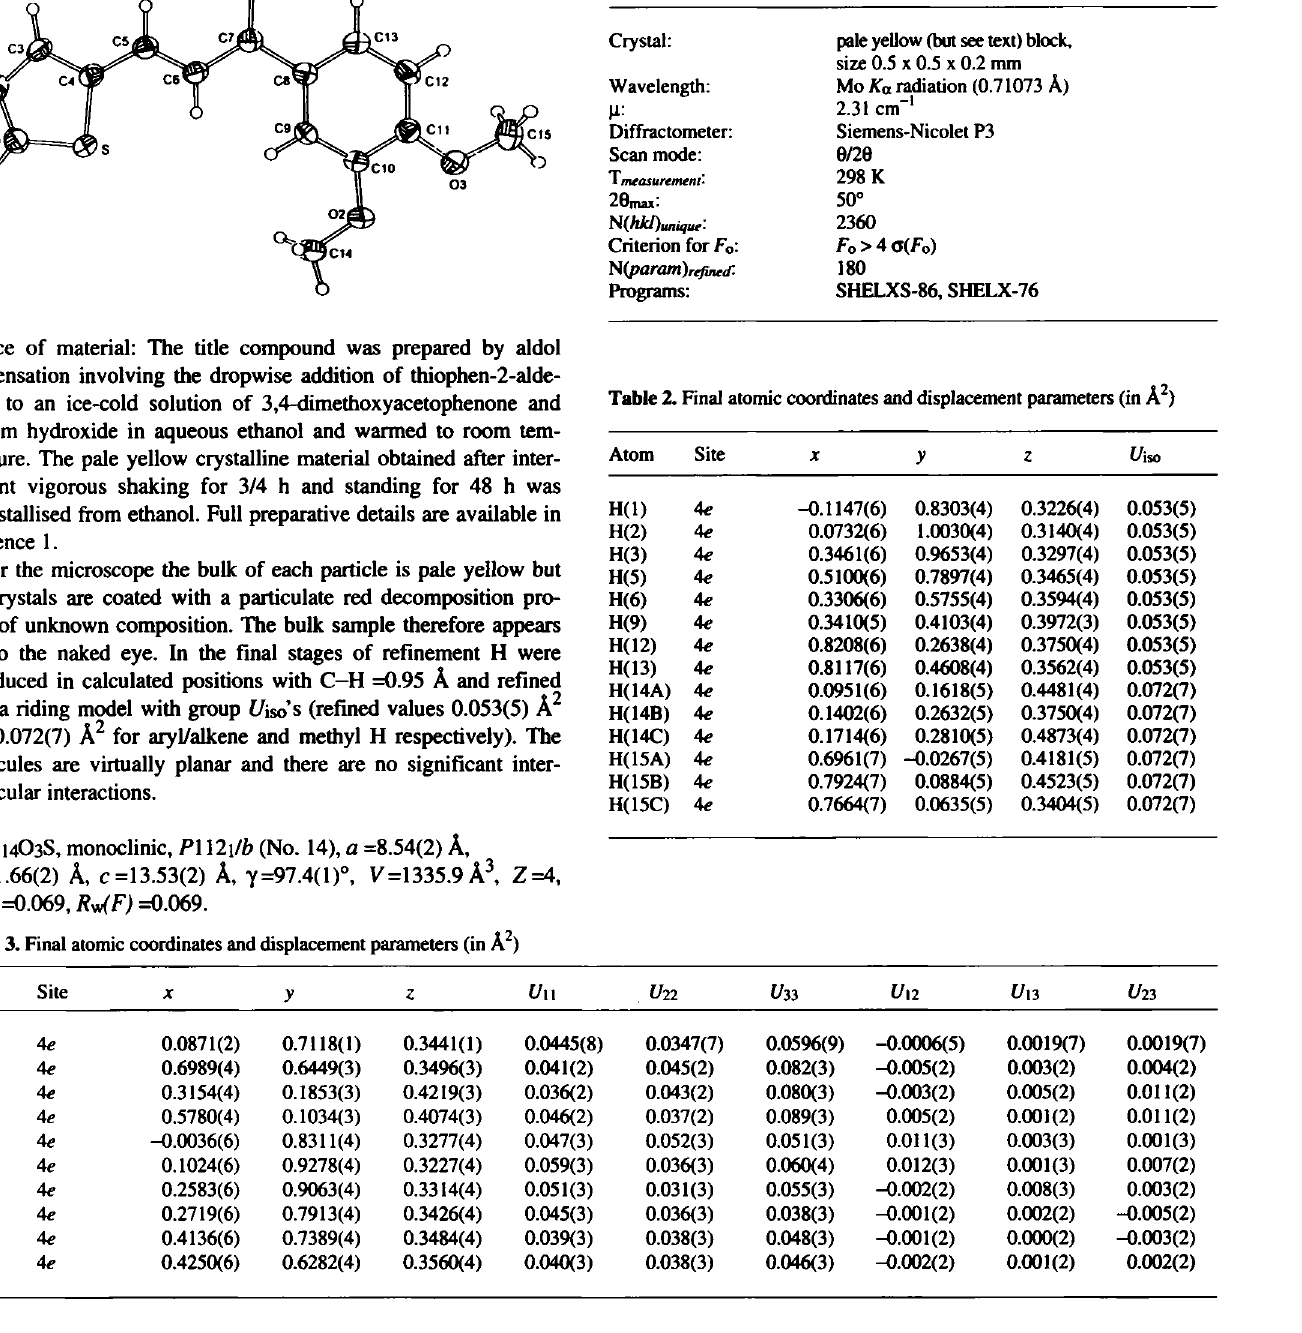
Table 1. Parameters used for the X-ray data collection